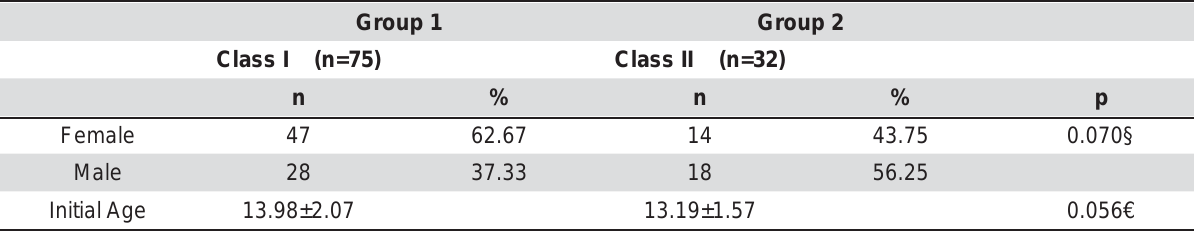
Table 1- Compatibility of Class I and complete Class II malocclusion groups regarding sex and age